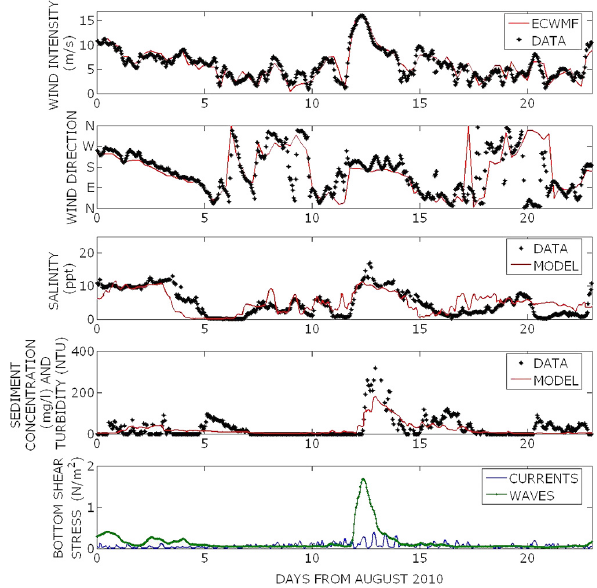
Fig. 3. Comparison between measured wind and ECWMF re- analysis (first and second panels); measured and modelled time se- ries of mid depth salinity (third panel); mid depth measured tur- bidity time series and mid depth modelled sediment concentration time series (fourth panel); and computed wave-induced and current- induced bottom shear stress (lower panel) at BB station during 23 days in August